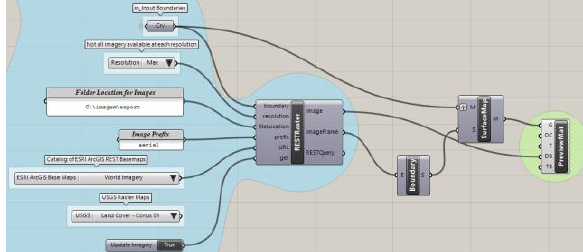
Figure 11: Obtaining the image of the study area